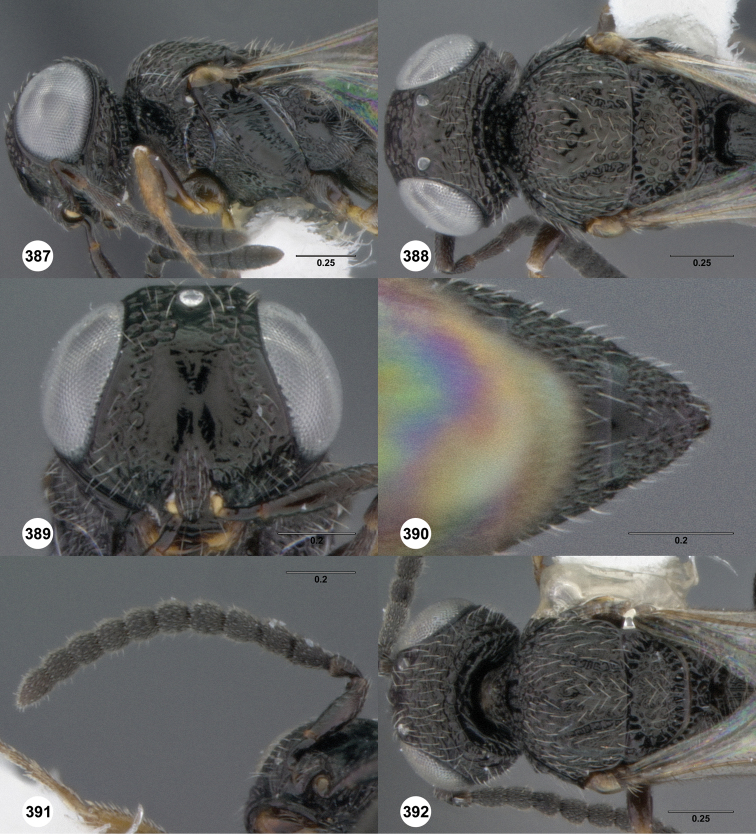
Oxyscelio valdecatenae sp. n., paratype female (OSUC 462580) 387 Head and mesosoma, lateral view 388 Head and mesosoma, dorsal view 389 Head, anterior view 390 Metasoma, dorsal view. Paratype male (OSUC 449000) 391 Antenna 392 Metasoma, dorsal view. Morphbank101